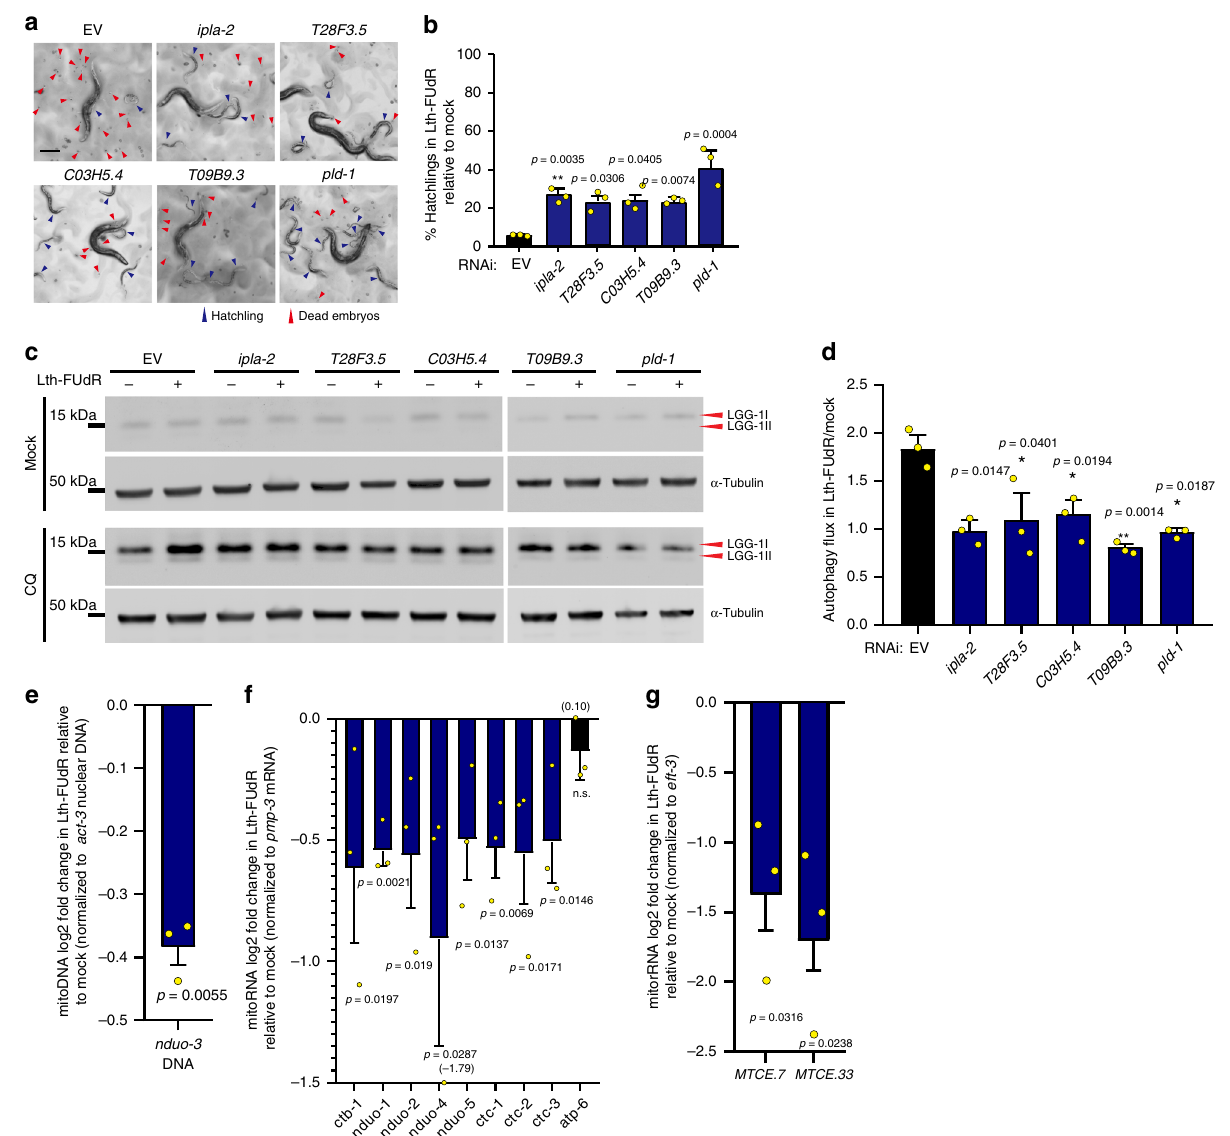
Fig. 6 Autophagy activation in Lth-FUdR depends on mitochondrial lipid metabolism. Throughout this fi gure: % hatchlings was analyzed as described in Fig. 1. Statistical signi fi cance for %hatchlings quanti fi cation was assessed via two-tailed unpaired nonparametric t -test. Statistical signi fi cance for western blotting ratio and qPCR fold change was assessed via one-tailed ratio t -test. Data are presented as mean values ± SEM, scale bars = 200 µ m. n = # independent biological replicates. Source data are provided as a Source Data fi le. a Representative images of progeny viability of C. elegans exposed to Lth- FUdR (7.5 μ g/mL) while cultured on EORB1 EV or RNAi-targeting mitochondrial genes. n = 3. b Quanti fi cation of treatments represented in a . n = 3. c Representative α LGG-1 western blotting analysis of worms exposed to ±Lth-FUdR (7.5 μ g/mL) ±8 h of 20 mM chloroquine while cultured on EORB1 EV or RNAi-targeting mitochondrial genes. Data acquisition as described in Methods. d Quanti fi cation of autophagy fl ux of treatments represented in c . Autophagy fl ux estimation and interpretation as described in Fig. 5h – I, main text, and Methods. n = 3. e qPCR analysis of mitochondrial DNA content ( nduo-3 ) relative to nuclear DNA ( act-3 ) in Lth-FUdR worms relative to mock. n = 3. f qRT-PCR analysis of the expression/stability of mitochondrially encoded mRNAs relative to the nuclearly encoded mRNA pmp-3 in worms treated with Lth-FUdR relative to mock. n = 3. g qRT-PCR analysis